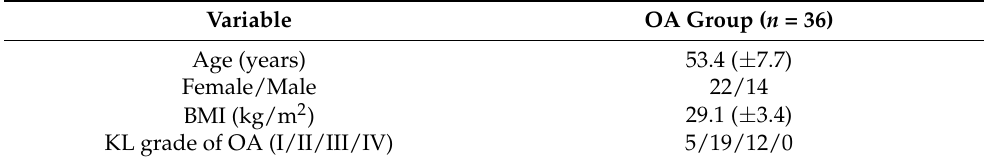
Table 1. Characteristics of the studied patients.